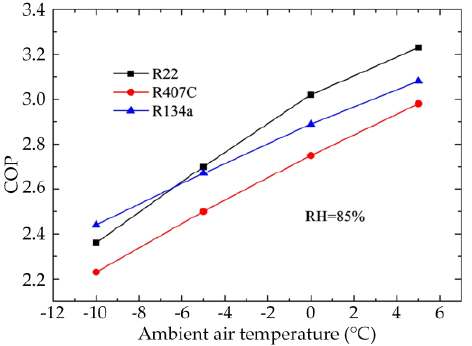
Figure 26. Effects of ambient air temperature on the COP of the FFASHP water heater system with three different refrigerants [85].